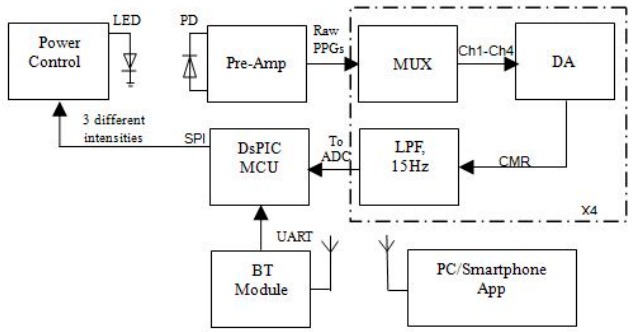
Figure 3. Block diagram of the OEPS circuit with six individual functional modules: (1) DsPIC MCU: microcontroller (dsPIC33FJ64GS610); (2) LPF: low-pass filter (fc = 15 Hz); (3) DA: differential amplifier;